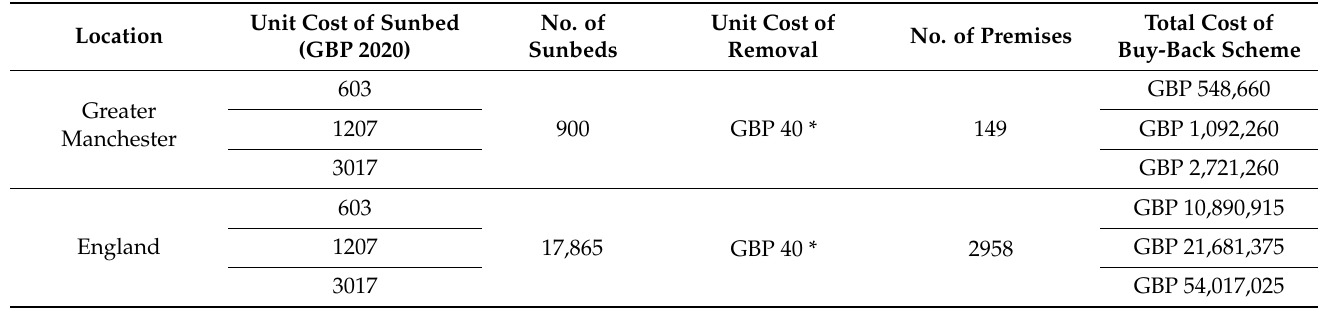
Table 3. Estimated cost of buy-back